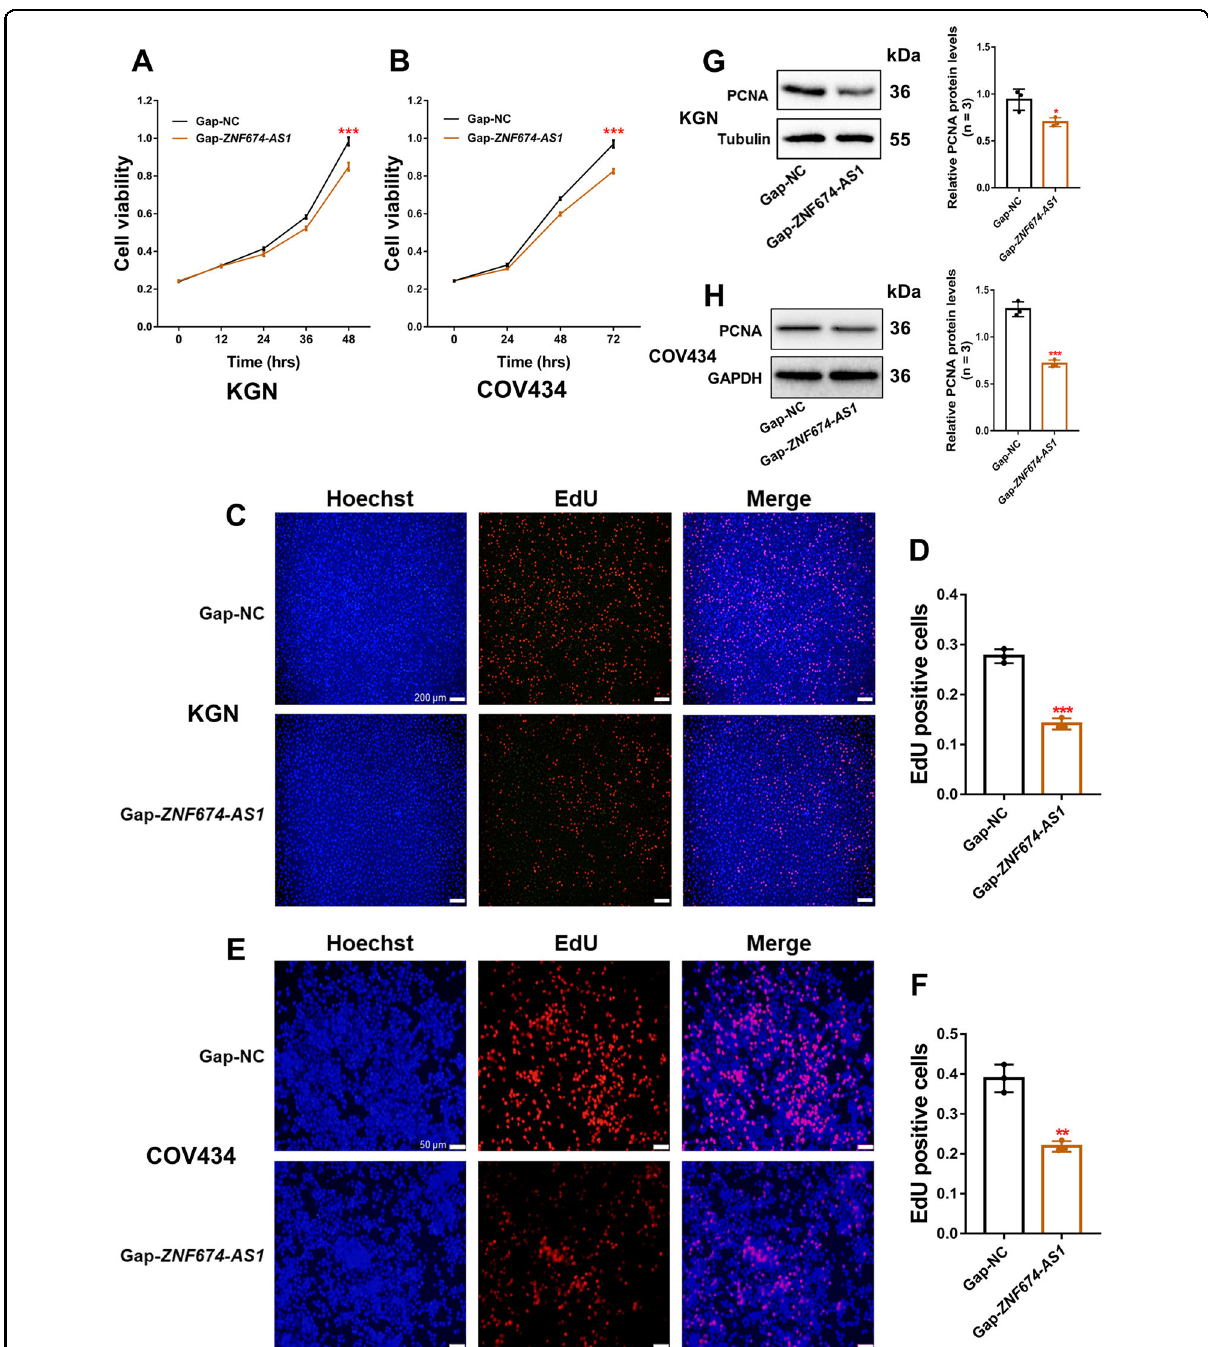
Fig. 2 Silencing of lncRNA ZNF674-AS1 signi fi cantly inhibited the proliferation of GCs. A , B The viability of KGN and COV434 cells after ZNF674- AS1 silencing was assessed by CCK8 assay. Results are expressed as the mean ± SD ( n = 3). *** p < 0.001 by two-tailed Student ’ s t test. C , D The proliferation of KGN cells after ZNF674-AS1 silencing was evaluated by EdU staining assay. Results are expressed as the mean ± SD ( n = 3). *** p < 0.001 by two-tailed Student ’ s t test. Scale bar: 200 μ m. E , F The proliferation of COV434 cells after ZNF674-AS1 silencing was evaluated by EdU staining assay. Results are expressed as the mean ± SD ( n = 3). ** p < 0.01 by two-tailed Student ’ s t test. Scale bar: 50 μ m. G , H PCNA protein levels in KGN and COV434 cells were analyzed by western blot after ZNF674-AS1 silencing. For gray value quanti fi cation of PCNA, data were normalized to the internal reference. Shown are mean ± SD. * p < 0.05, *** p < 0.001 by two-tailed Student ’ s t